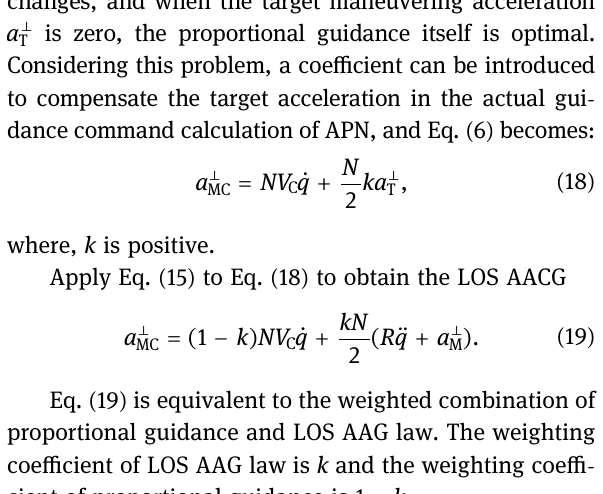
Figure 1: Two - dimensional plane interception geometric